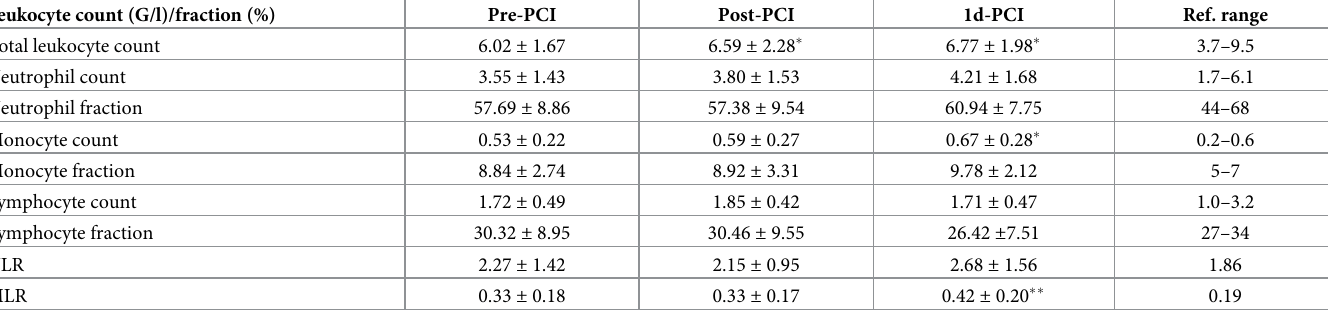
Table 1. Leukocyte counts, fractions, NLR and MLR of our stable CAD patients directly before (pre-PCI), directly after stenting (post-PCI) and on the next day (1d-PCI). Leukocyte count (G/l)/fraction (%)